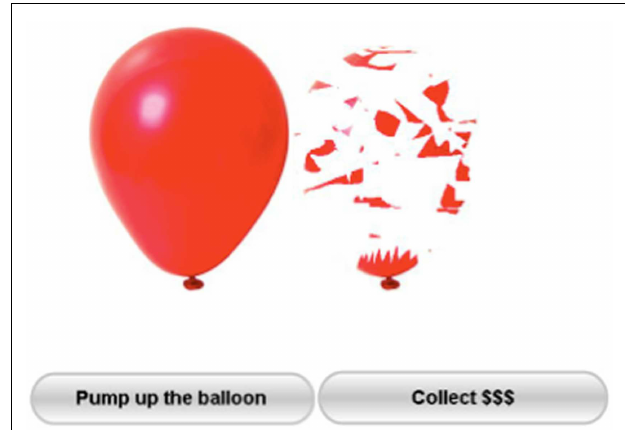
FIGURE 1 |The BART test . Participants press the button “pump up the balloon” to inflate puffs of air into a balloon presented on a computer screen. Every successful pump adds 5cents to their temporary bank for that trial. If the balloon explodes before the participant presses the “collect $$$” button then nothing is won on that